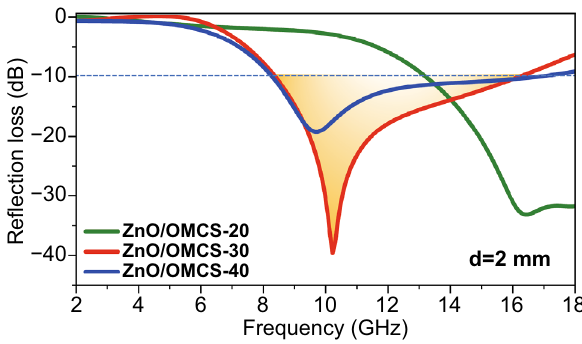
Fig. 9 Reflection loss for ZnO/OMCS with different ZnO contents under a constant thickness of 2 mm